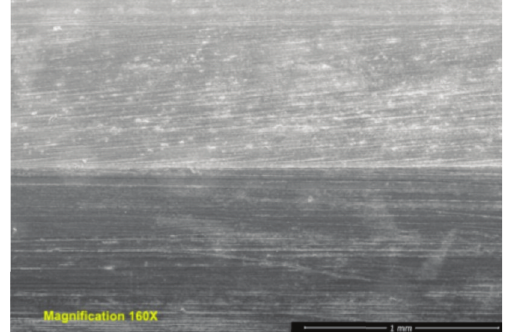
SEM image from inferior ridge of the FNE from patient Fig. 9: without medial migration showing only longitudinal scratch marks. No transverse scratch marks were seen.